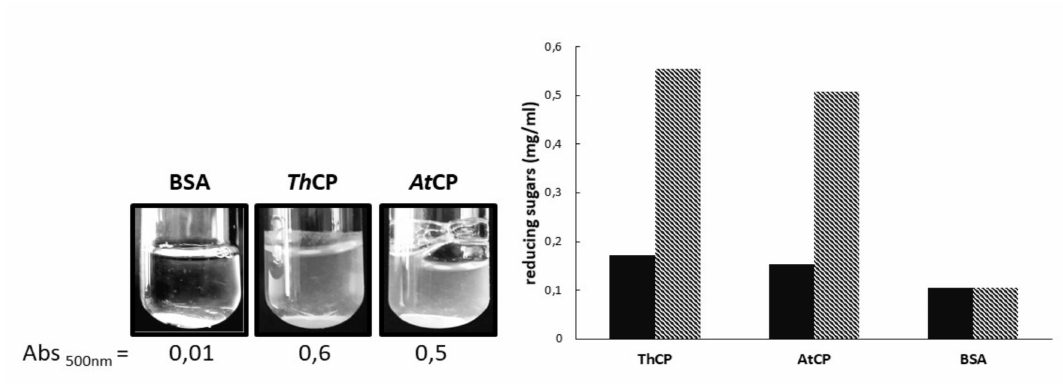
Figure 5. Left panel: protein samples (0.05 mg / mL), after incubation for three days at 37 ◦ C in the presence of a paper disc, and the corresponding absorbance values at 500 nm. Right panel: concentration of reducing sugars (RS) measured for each sample. Continuous black columns: RS determined on the supernatants of the samples described above. Dashed columns: RS determined on the samples described above, further incubated with cellulase (1 U tot). 0.05 mg / mL. Bovine serum albumin (BSA) was used as reference.